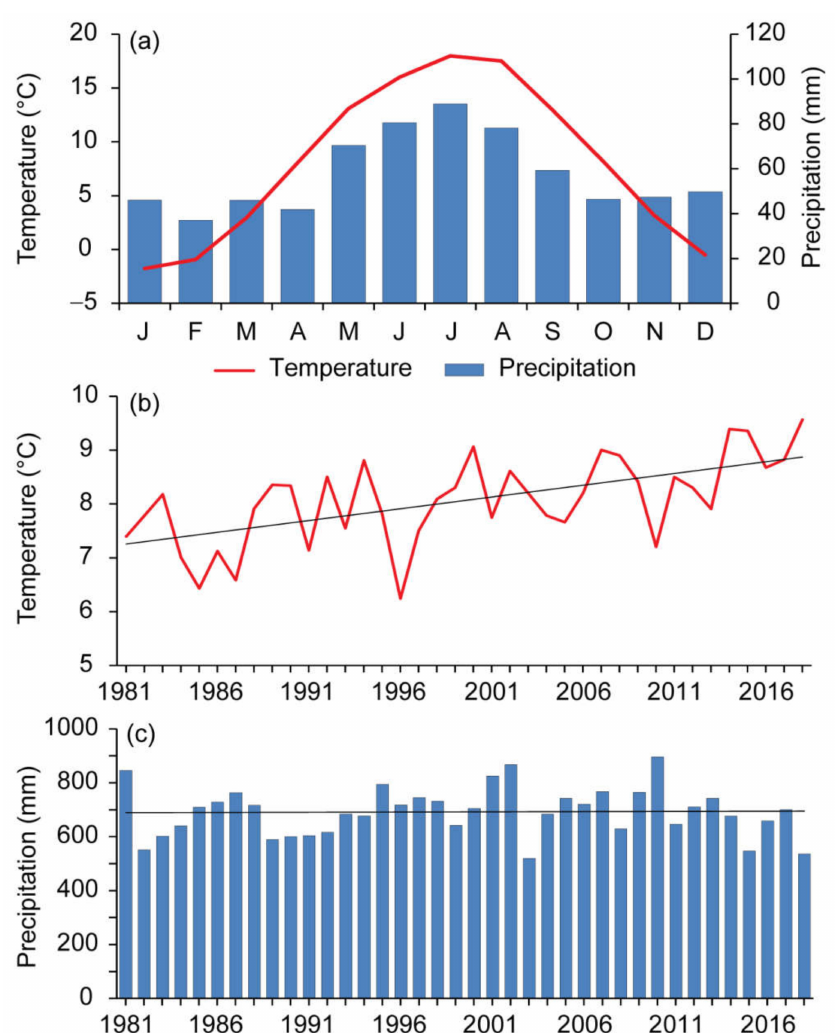
Figure 1. Climatic patterns of the Czech Republic in the 1981–2018 period, based on mean Czech temperature and precipitation series: ( a ) annual variations in mean monthly temperatures and precipitation; ( b ) fluctuations in mean annual temperature series; ( c ) fluctuations in annual precipitation series (series in ( b ) and ( c ) are supplemented by linear